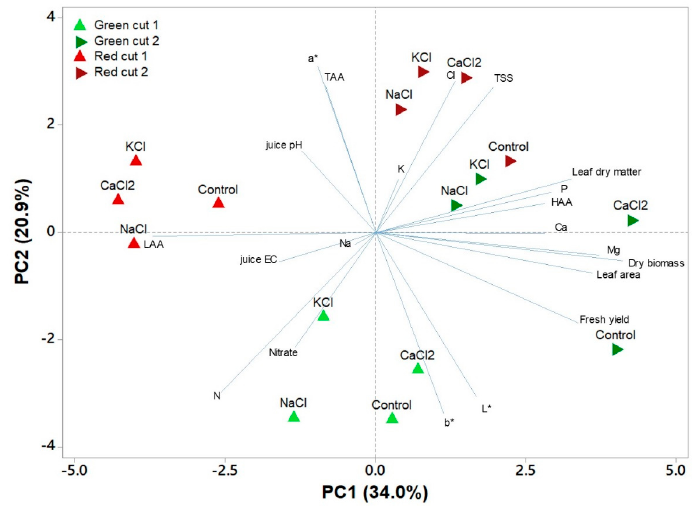
Figure 1. Principal component loading plot and scores of principal component analysis (PCA) of biometric traits, leaf colorimetry, flavor compounds, mineral composition, bioactive compounds, and antioxidant activity of green and red pigmented lettuces under four salinity treatments (control, CaCl 2 , KCl, and NaCl) and two successive